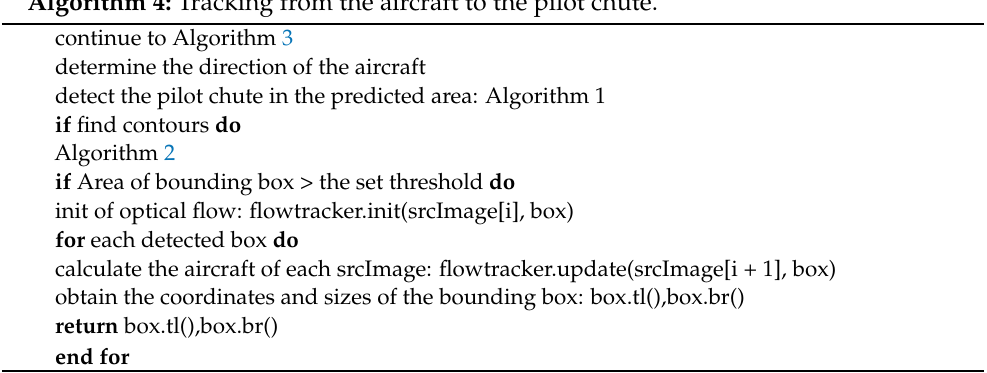
Figure 15. Capture and track the aircraft. ( a ) The pilot chute target capture; ( b ) transfer the coordinates and size of the box to the corresponding original image. Algorithm 4: Tracking from the aircraft to the pilot chute.